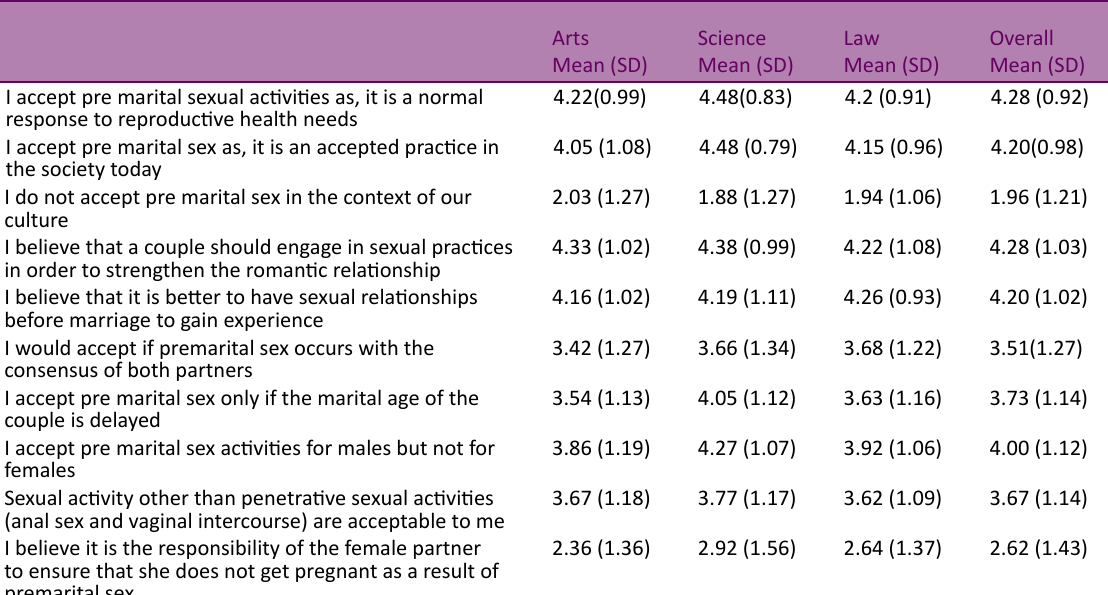
Table 2 – Mean score (SD) on attitudes of female students of the three Faculties on premarital sexual